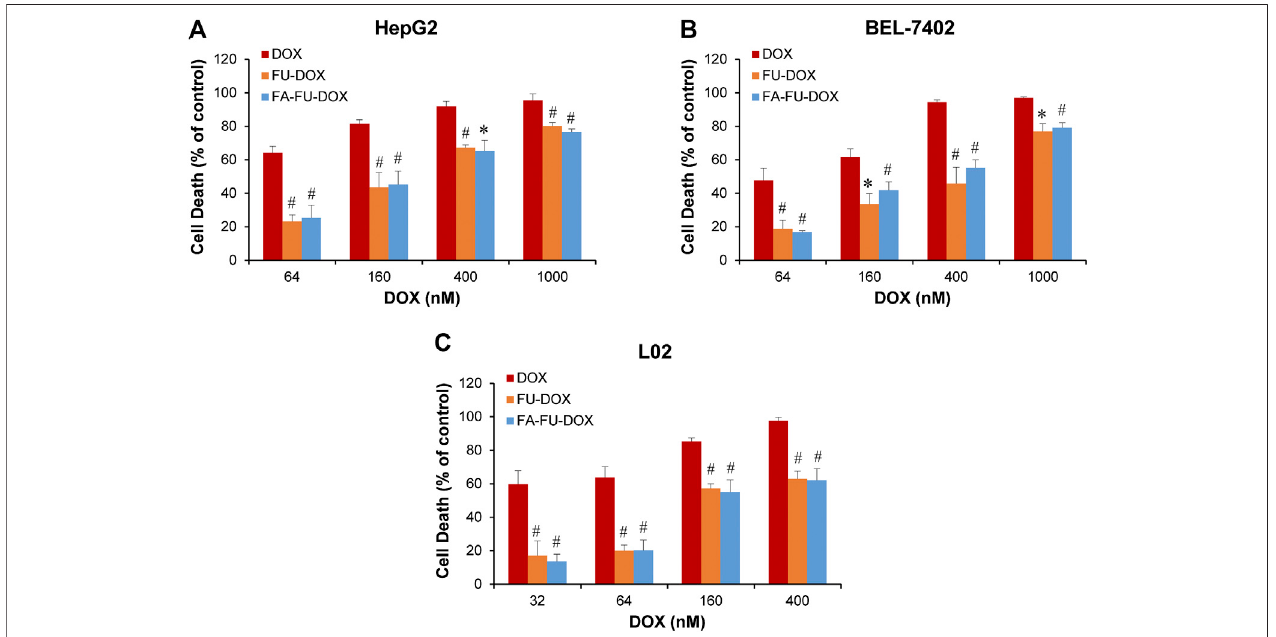
FIGURE 7 | In vitro cytotoxicity of DOX, FU-DOX, and FA-FU-DOX. (A) HepG2, (B) BEL-7402, and (C) L02 cells were exposed to various concentrations of DOX, FU-DOX, and FA-FU-DOX for 72 h for determination of cell death by CCK-8 assays. Data represent mean ± SD from three independent experiments (* p < 0.05 and # p <